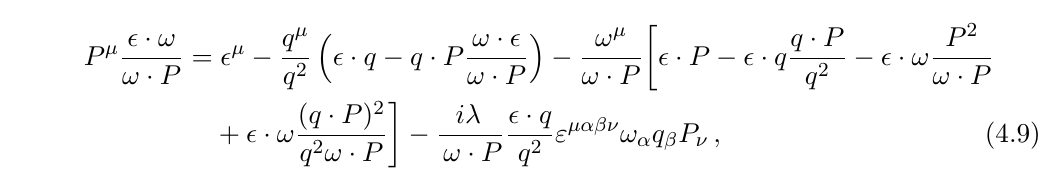
Figure 2 . The dependences of (cid:1) A 3 at q 2 = (0 ; 9) GeV 2 and for D (cid:3) ! (cid:26) transition at q 2 ? explanations and